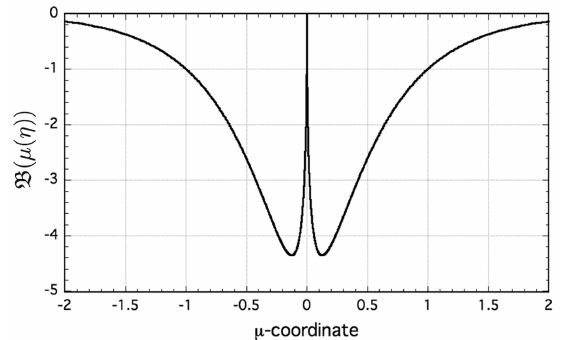
Figure 5. Theoretical cooling distribution for an equilibrated grain boundary groove with zero dihedral angle. Maximum cooling rates occur at µ max ≈ ± 0.13. This unique distribution of capillary-mediated heat removal provides a robust target for independent verification, by comparing these theoretical cooling rates against those measured by direct equilibration of an equivalent grain boundary groove simulated using multiphase-field